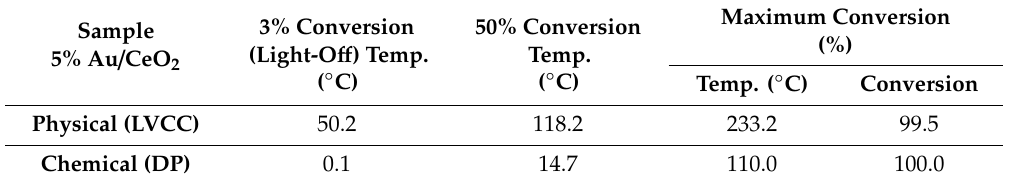
Table 2. Comparison of the catalytic activities of as-synthesized Au / CeO 2 (first light-o ff ) prepared by LVCC and DP methods.